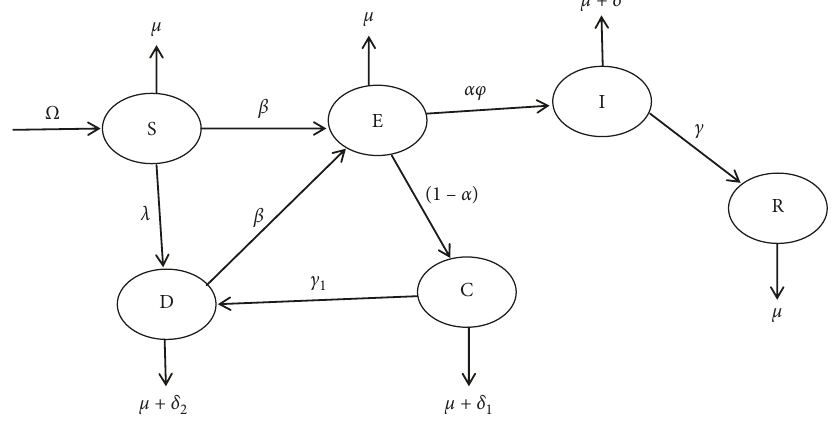
Figure 1: Schematic diagram of diabetes-COVID-19